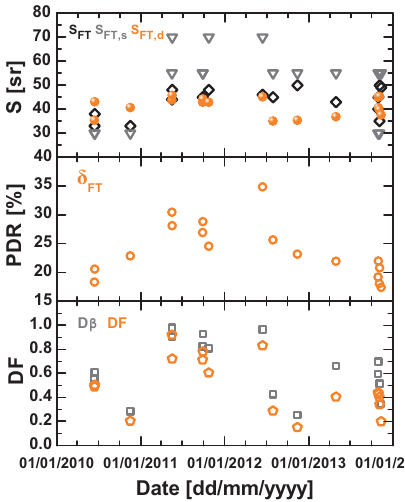
Figure 5. (Top) Retrieved FT 532nm lidar ratio S FT (black dia- monds), dust-related lidar ratio S FT,d (orange circles), and assumed non-dust lidar ratio S FT,s (gray triangles) for 17 Middle East dust outbreaks, (center) mean 532nm particle linear depolarization ratio δ FT for the FT dust layer, and (bottom) 532nm AOT dust fraction DF (orange pentagons, Eq. 3), and FT dust backscatter fraction D β (gray squares, Eq. 1).